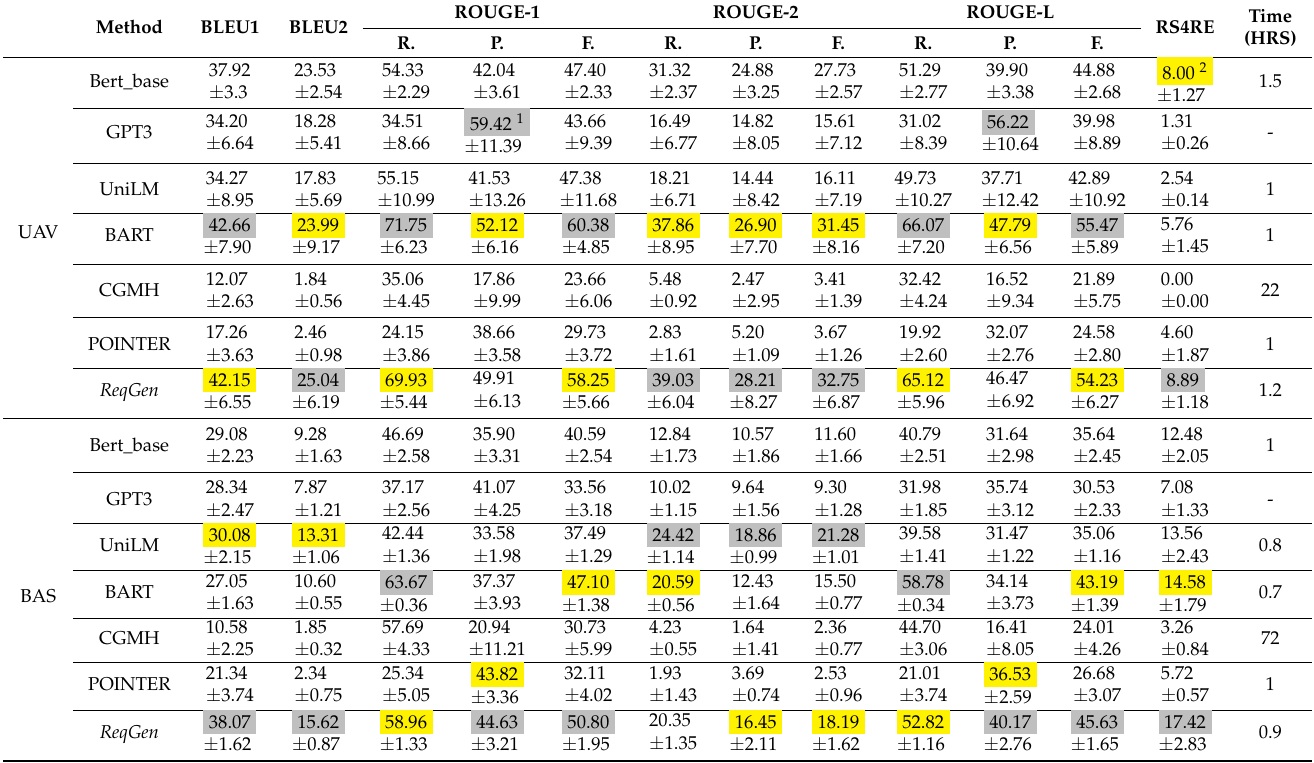
1 Grey background: Best results for each metric. 2 Yellow background: Second-best results for each